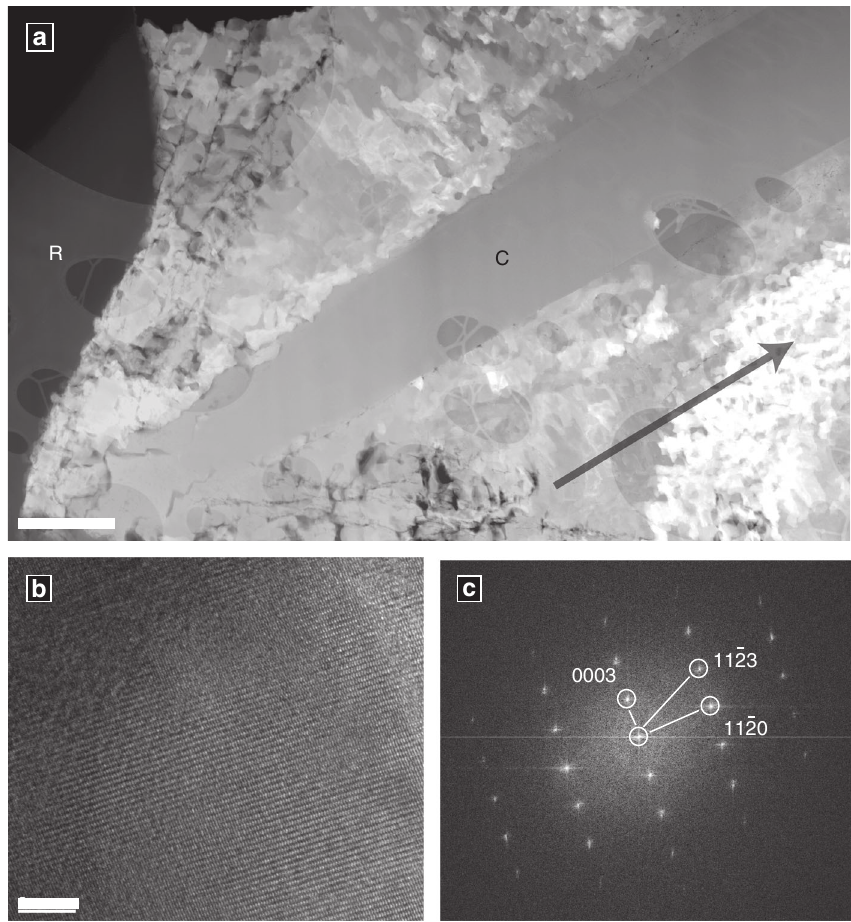
Fig. 6 Post-transformation structure in N. dutertrei shells. a Foil #4483 cut from a post-transformation shell displays a large calcite single crystal (C) that disrupts the underlying particulate structure. The dark margin on the left (R) is the sample mounting resin, and the arrow in the lower right points orthogonally towards the inner shell surface. High-resolution TEM ( b ) and indexed Fourier Transform diffraction pattern ( c ) show the crystal is calcite (see also Supplementary Fig. 6). Scale bars 1 µ m ( a ), 500 nm ( b ). All analyses carried out in analytical session